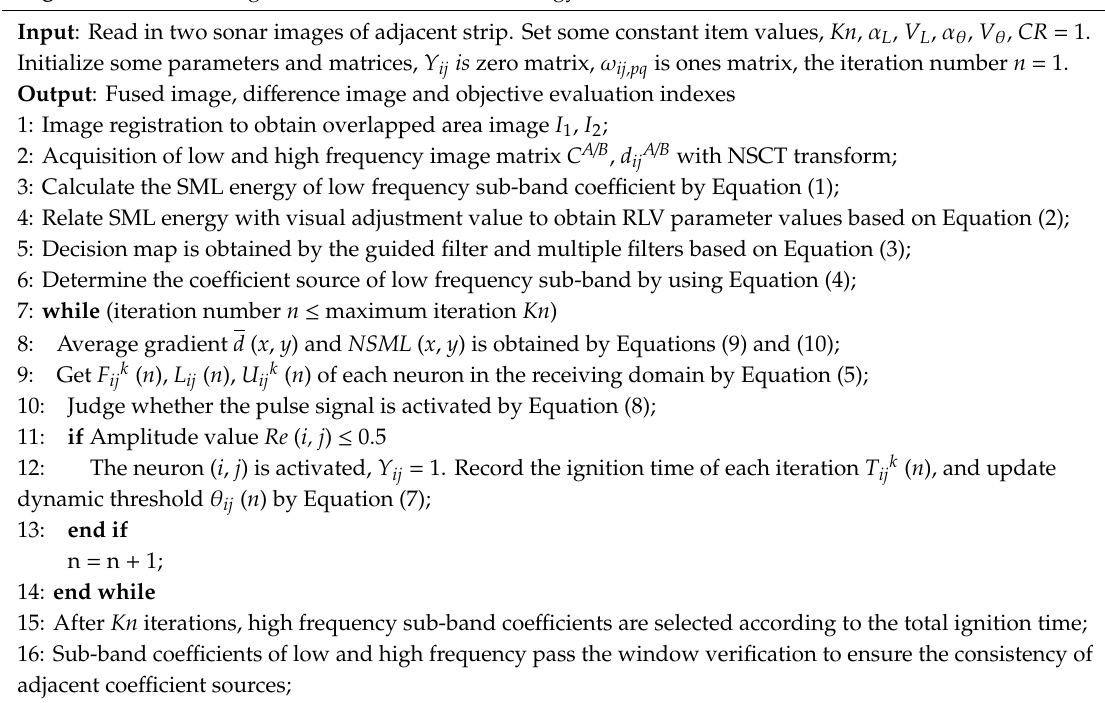
Algorithm 1 Sonar Image Fusion Based on SMLF energy and IDPCNN